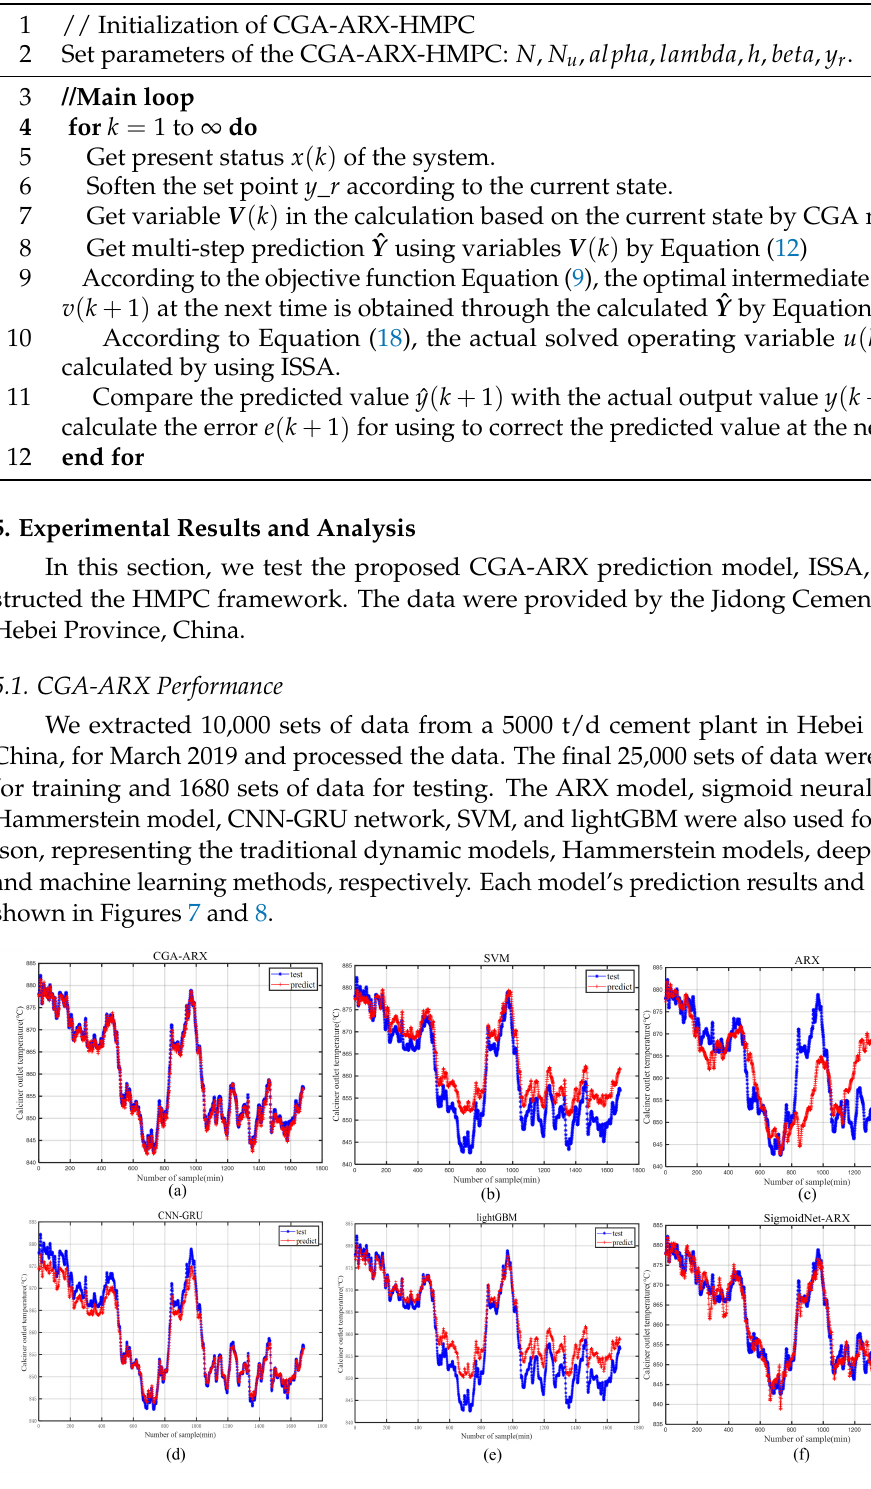
Table 3. Pseudo-code of CGA-ARX-HMPC algorithm.